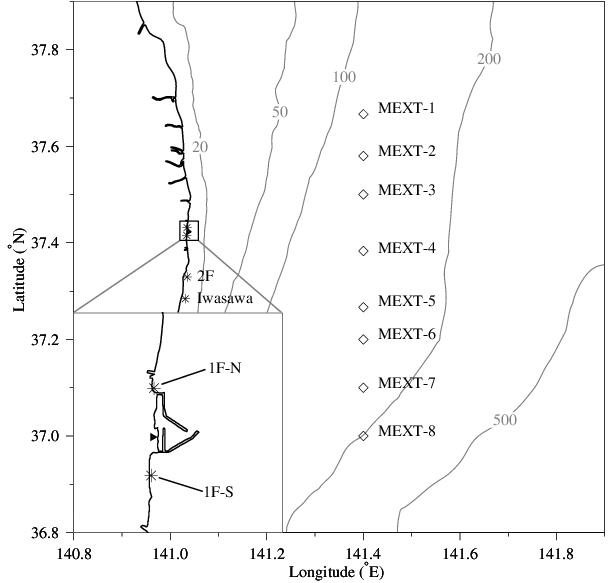
Fig. 2. Locations of the north discharge canal (1F-N) and the south discharge canal (1F-S), the 2F and Iwasawa stations at south of 1F- S and the eight MEXT sampling sites 30km off the coast. The filled triangle indicates the location of the discharge source for leaking 137